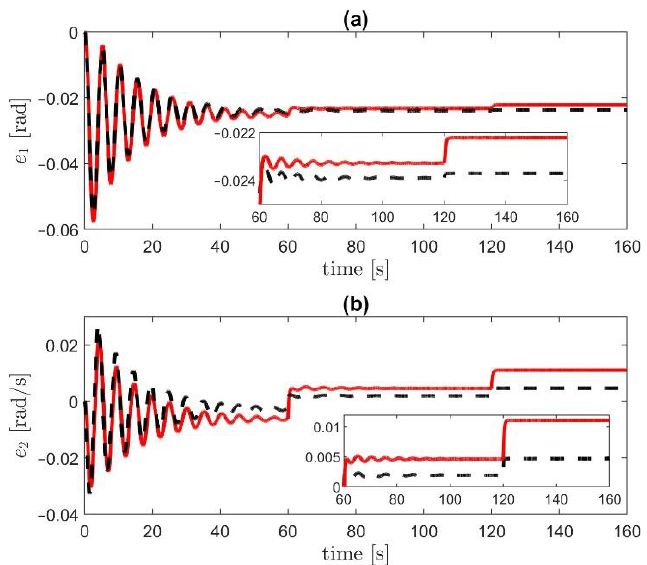
Figure 8. Influence of the parameter changes on observer error 𝑒 1 ( a ) and 𝑒 2 ( b ). Dashed black line — 𝛼 = 7 , solid red line — 𝛼 = 5 .